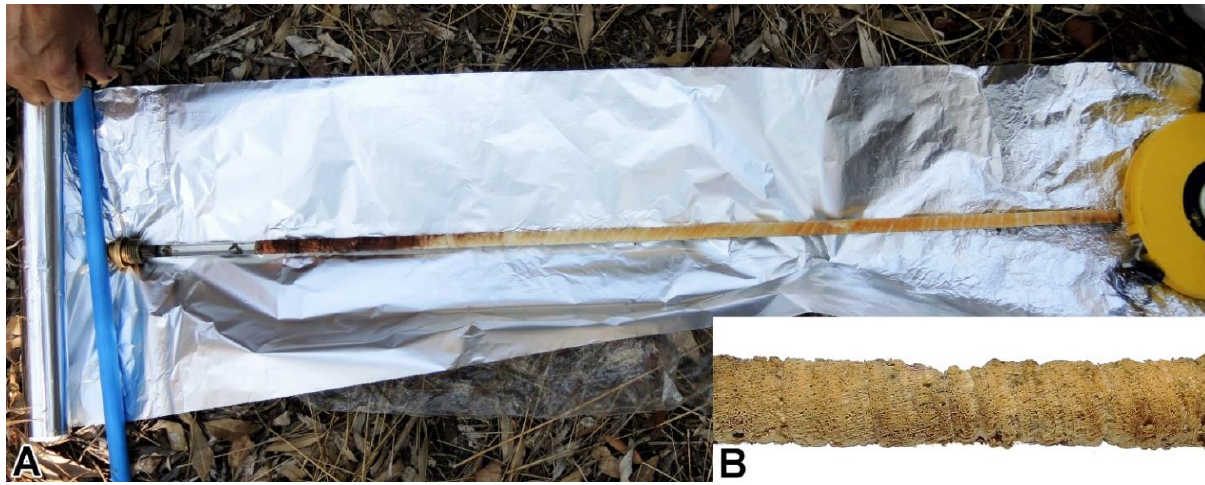
Figure 8. Photo showing sample A 257-1 being extracted from the increment borer to be wrapped in tin foil until further investigation ( A ). Detail of sample A 257-1, showing the growth rings, which typically become obvious 7–10 days after sampling ( B ).